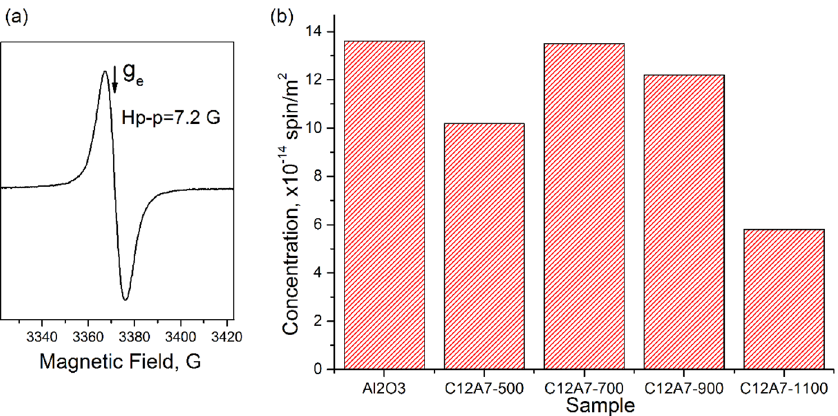
Figure 5. ( a ) Typical EPR spectrum of radicals appearing after the adsorption of anthracene on γ - Al 2 O 3 and C12A7 samples. ( b ) The concentration of radicals arising from the adsorption of anthracene molecules on acceptor sites. The given concentration values are referred to as the unit surface of the samples.